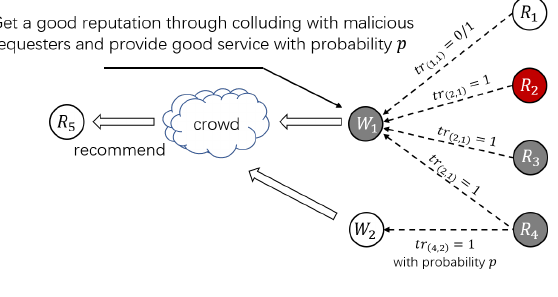
Figure 4. Threat Pattern